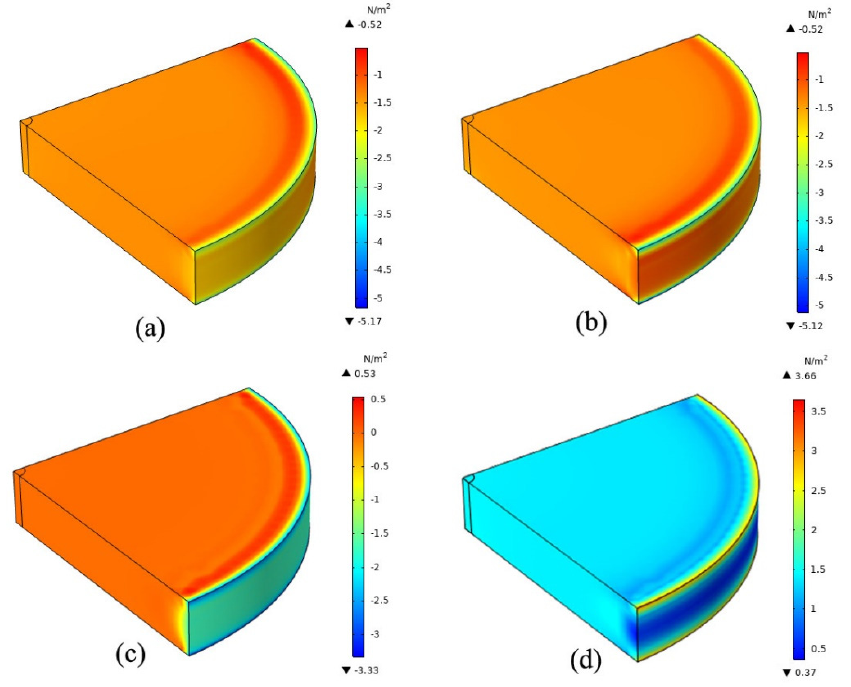
Figure 3. ( a – d ) are the simulation results of the typical stress σ xx , σ yy , σ zz and σ v (von mises stress) curves of the silicon wafer surface under 17,000 W/cm 2 laser irradiation for 60 s,